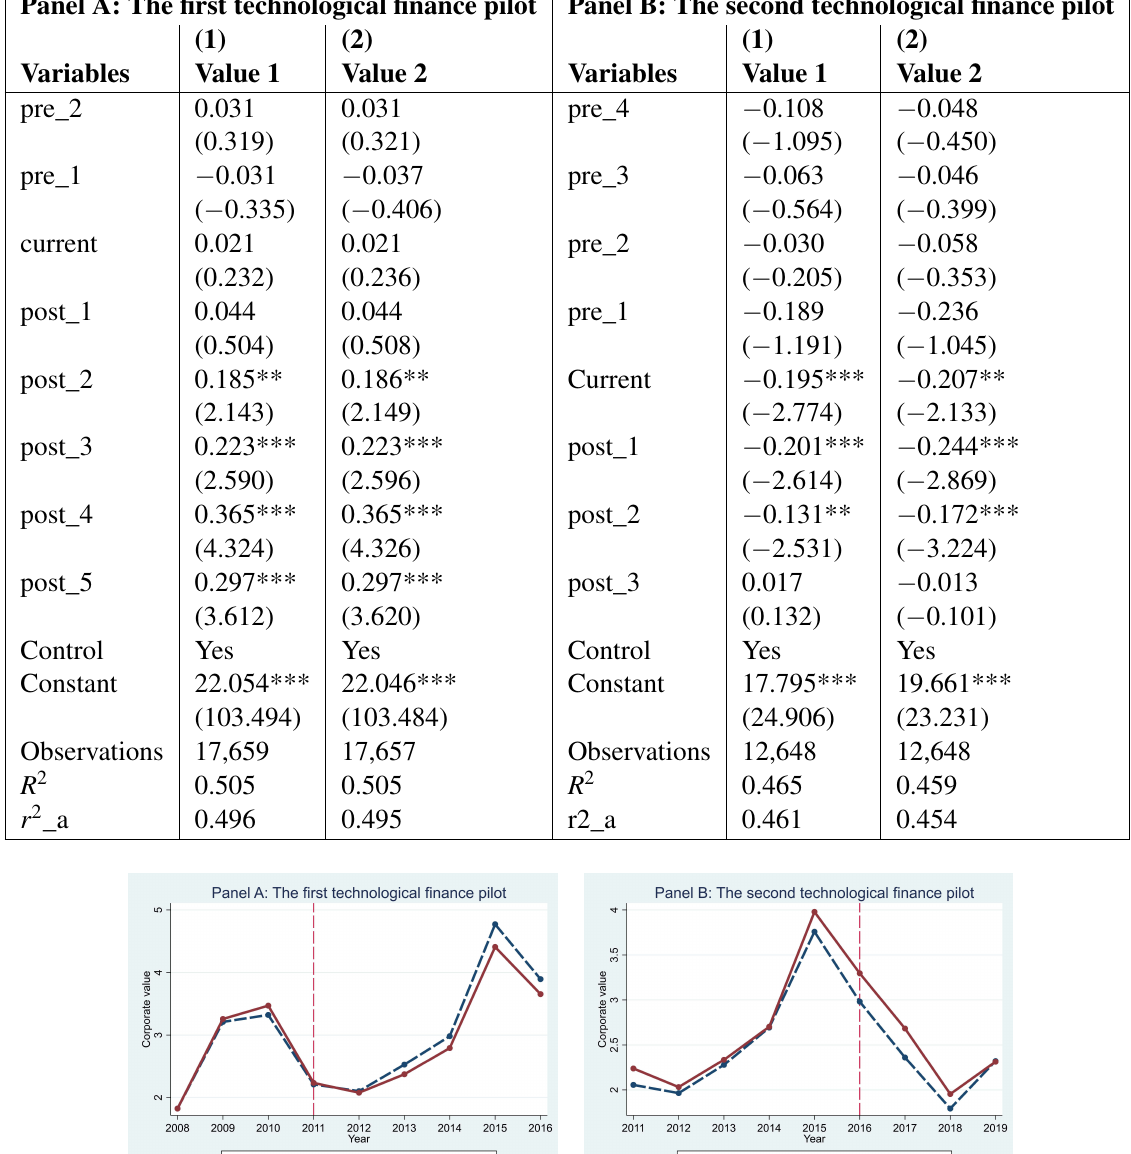
Table 4 Test results of the common trend of corporate value in two technological finance pilot areas Panel A: The first technological finance pilot